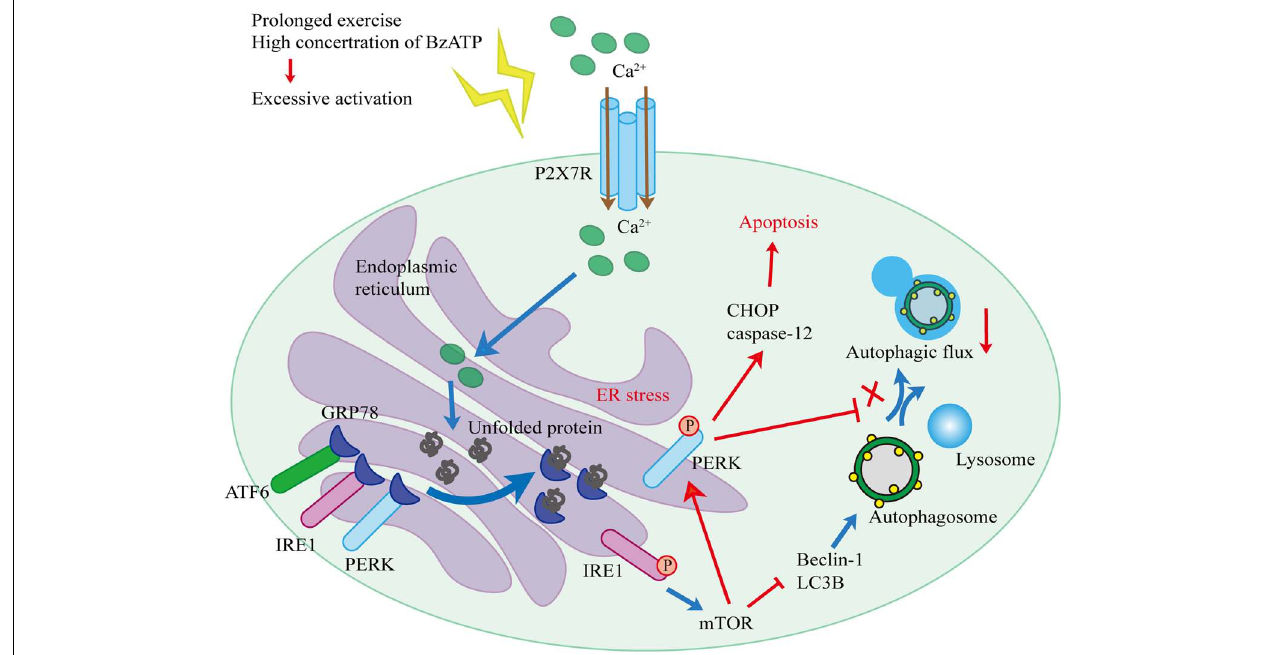
FIGURE 10 | Schematic diagram of the working